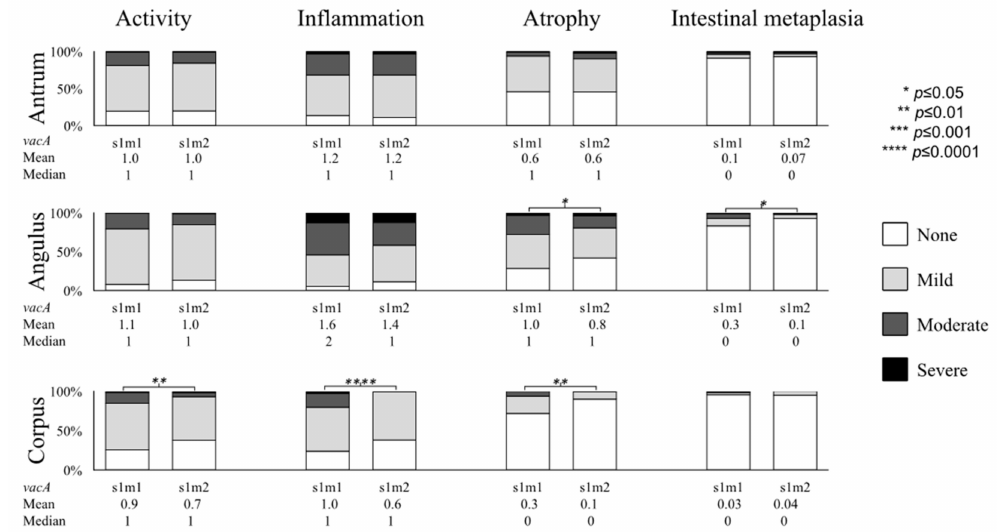
Figure 4. The vacA s1m1 versus s1m2 subtypes based on histological status. The distribution and the mean values of histological features of gastritis based on vacA genotyping are